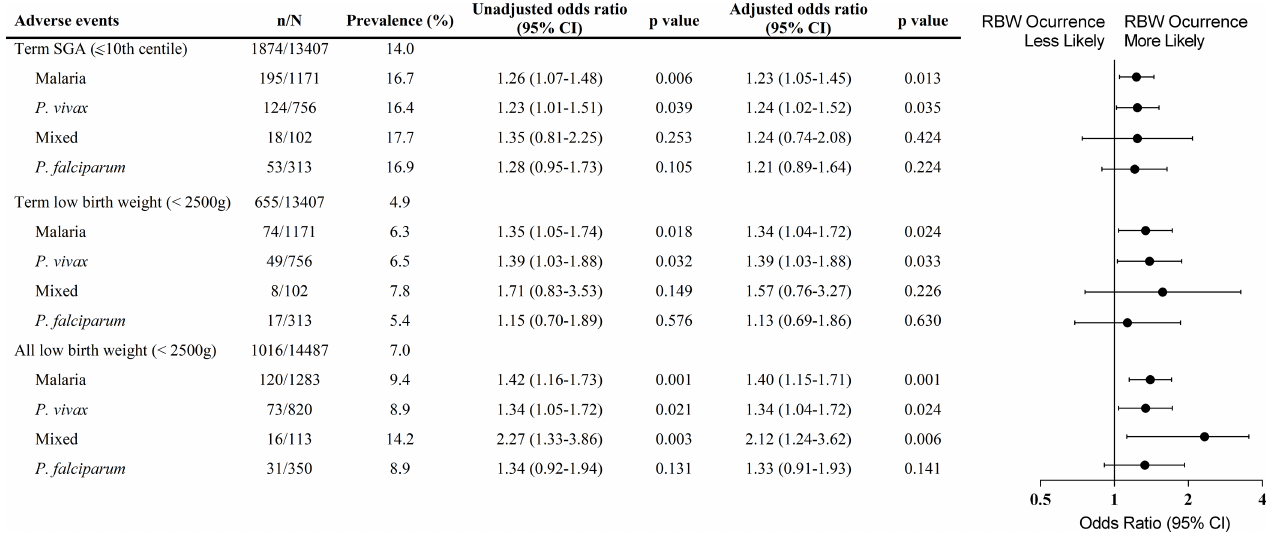
Fig 4. Forest plot of the odds ratio for weight reduction in newborns from women infected during pregnancy compared to babies from non-infected women, according to Plasmodium species. Each model adjusting for maternal age, gravidity and years of formal education (less than 4 years); mixed infection ( P . vivax and P . falciparum -infection). p values were estimated through logistic regression methods. n, number of events; N, total number in each group; CI, confidence interval; SGA, small for gestational age; LBW, low birth weight.